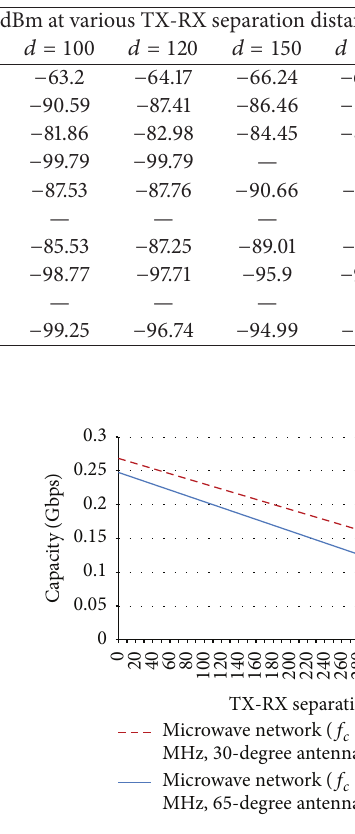
Figure 4: Capacity trend in Gbps for 900 MHz microwave networks using 65 ∘ and 30 ∘ transmitting antenna